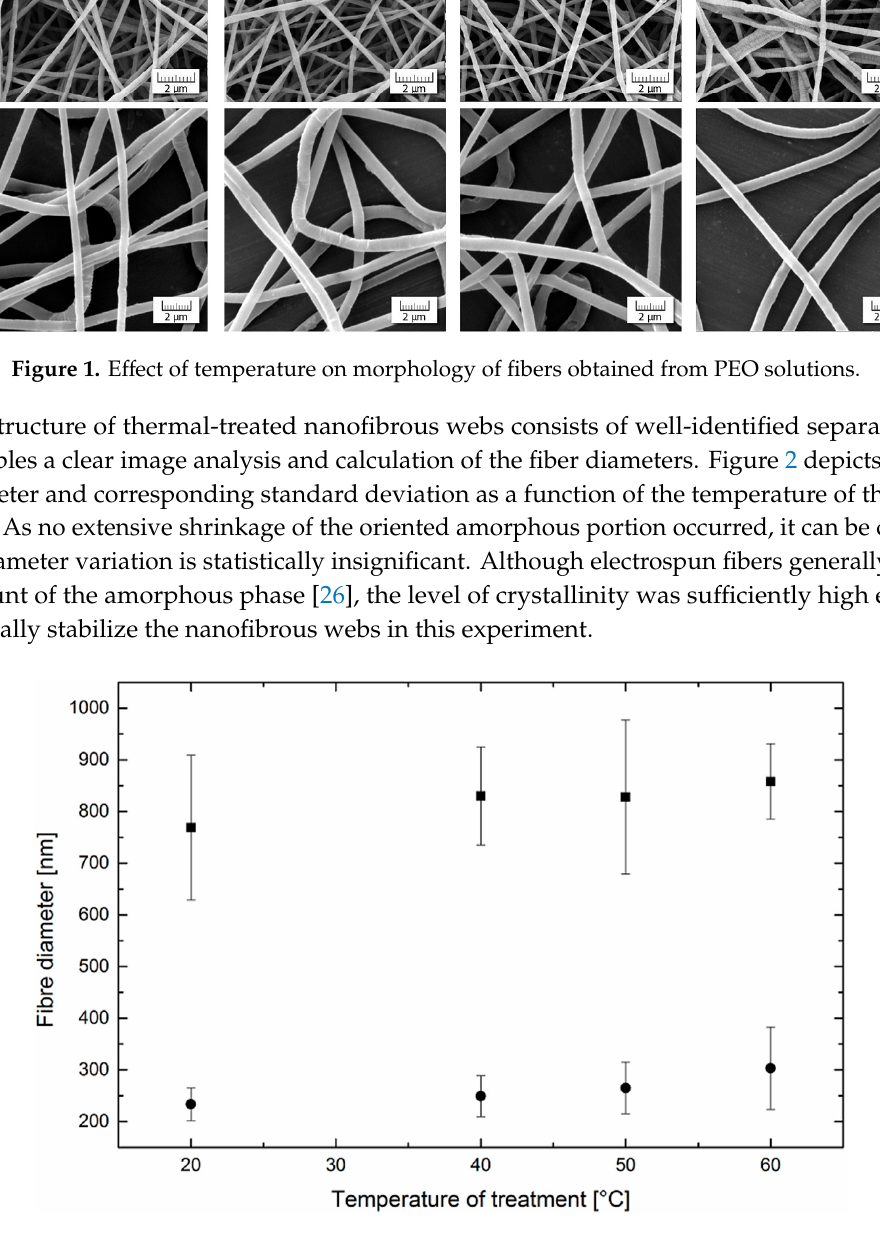
Figure 2. Effect of temperature on the diameter of fibers obtained from PEO solutions. Square symbols denote methanol solutions and circles denote water solutions.